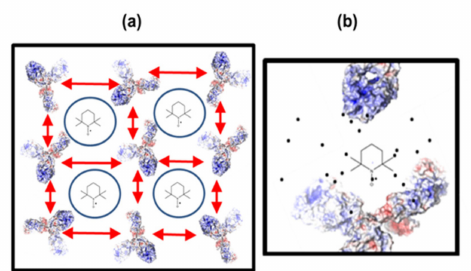
Figure 7. Sketch of potential spin probing of ( a ) interstitial water volumes in mAb1 solutions at high concentrations in purely aqueous solution, here shown as blue circles. The red double-headed arrows indicate attractive and repulsive electrostatic interactions between mAb1 molecules. ( b ) Potential direct probing of protein-rich volumes when bu ff er is added to high-concentration solutions as seen with